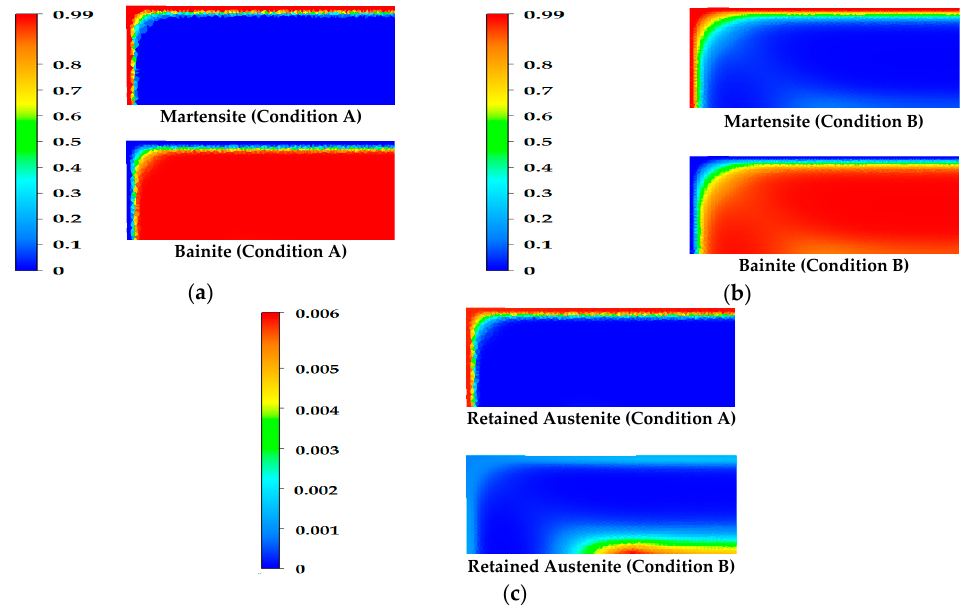
Figure 5. Distribution of phased transformed in the section A-A (1/8 model) after quenching process under various simulation conditions (A: uniform grain size and uniform %C, B: uniform grain size and variable %C). ( a ) Contour of martensite and bainite distributions under the condition of A; ( b ) Contour of martensite and bainite distributions under the condition of B; ( c ) Contour of retained austenite distribution under the conditions of A & B.